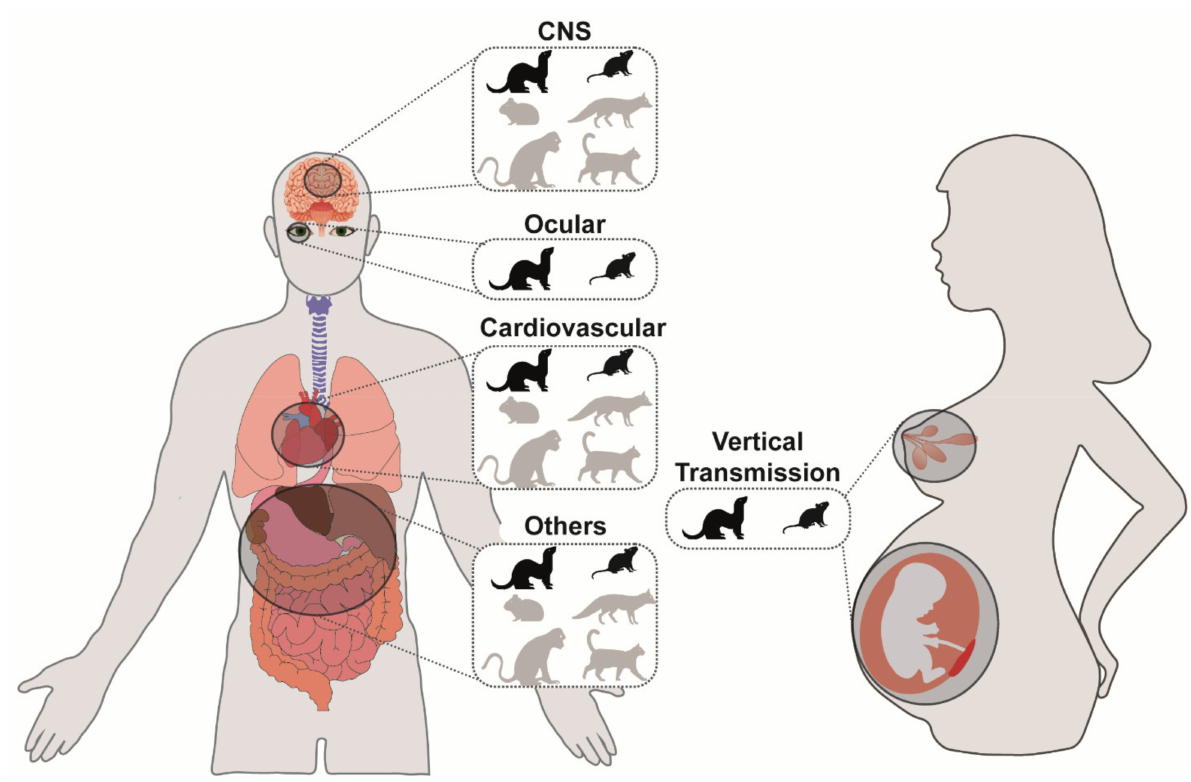
Figure 2. Animal models to study different extra-respiratory complication. Circles depict organs in which influenza A viruses have been detected, and which are discussed in the review. In the zoom out, established experimental animal species to study extra-respiratory spread of each organ are represented. In black are the animal models that have been used and described most